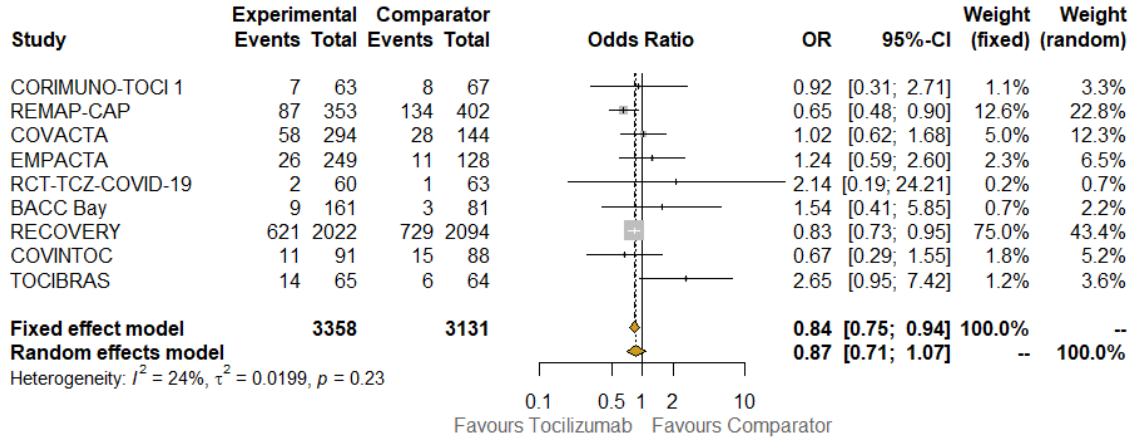
Figure 2. Overall meta-analysis of 28/30-day mortality. Abbreviations: OR, odds ratio; 95% CI, confidence intervals at 95%; Weight (fixed), weight of each study in a fixed-effect model; Weight (random), weight of each study in a random-effect model. Squares on the hazard ratio plot are proportional to the weight of each study; weighting is based on the inverse variance method.